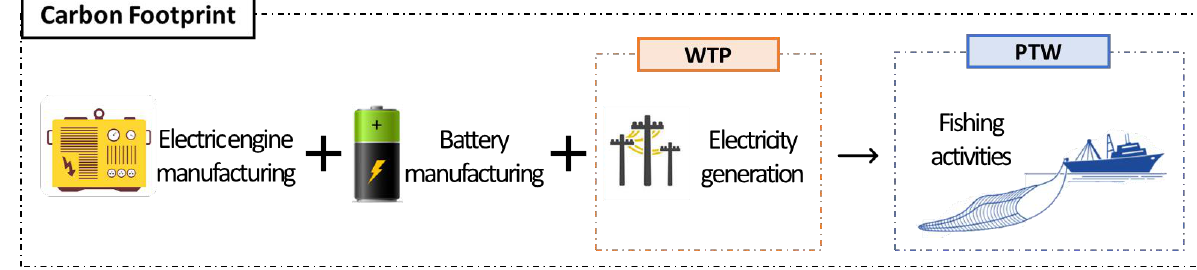
Figure 5. The LCA of a battery-powered trawler.